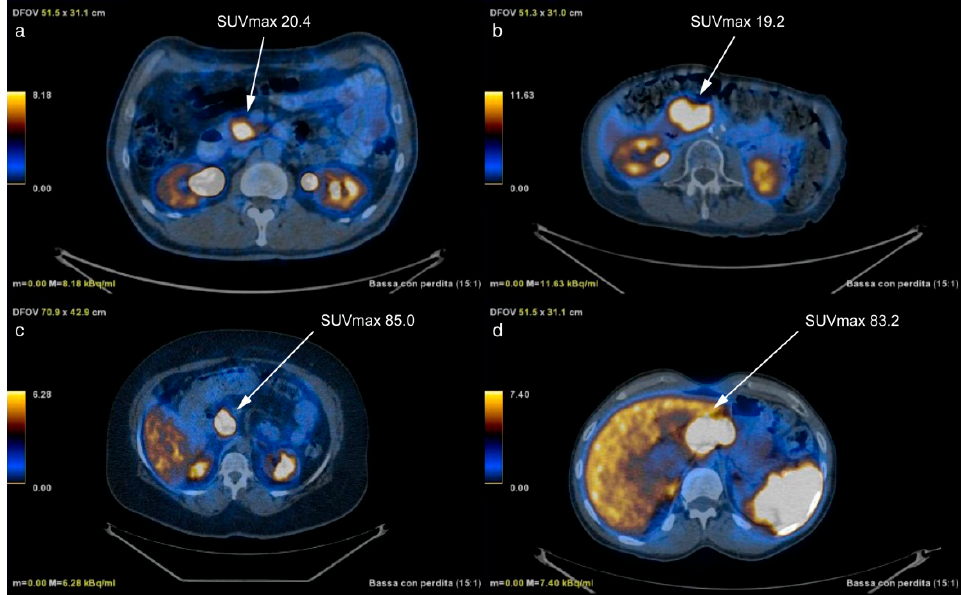
Figure 3. [68Ga]Ga-DOTANOC PET/CT transaxial fused images of two pairs of patients presenting similar SUVmax values of the primary lesion but different tumour grades. In particular,